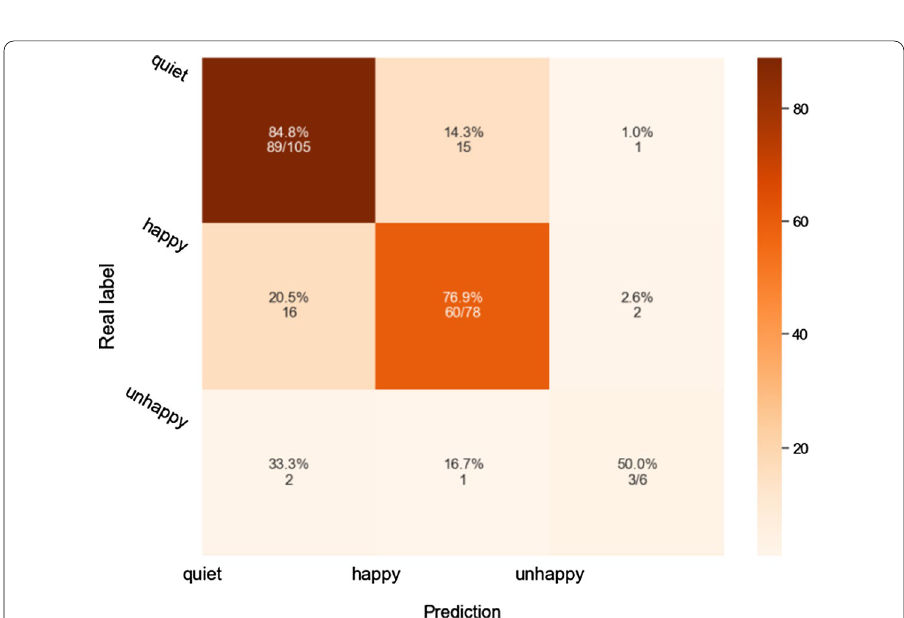
Fig. 18 Confusion matrix of the proposed emotion recognition